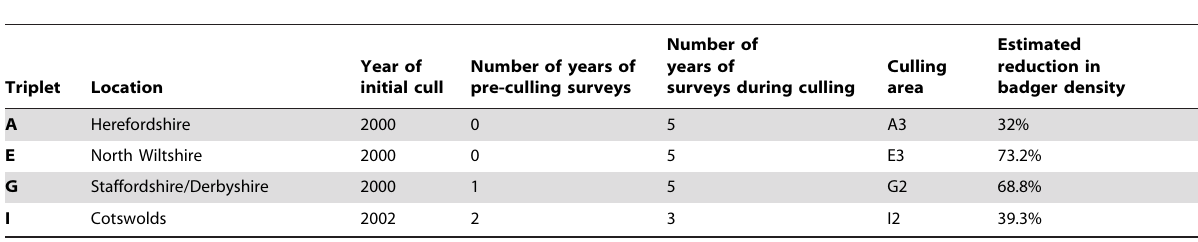
Table 1. The number of years of hedgehog surveys that were carried out in each triplet.